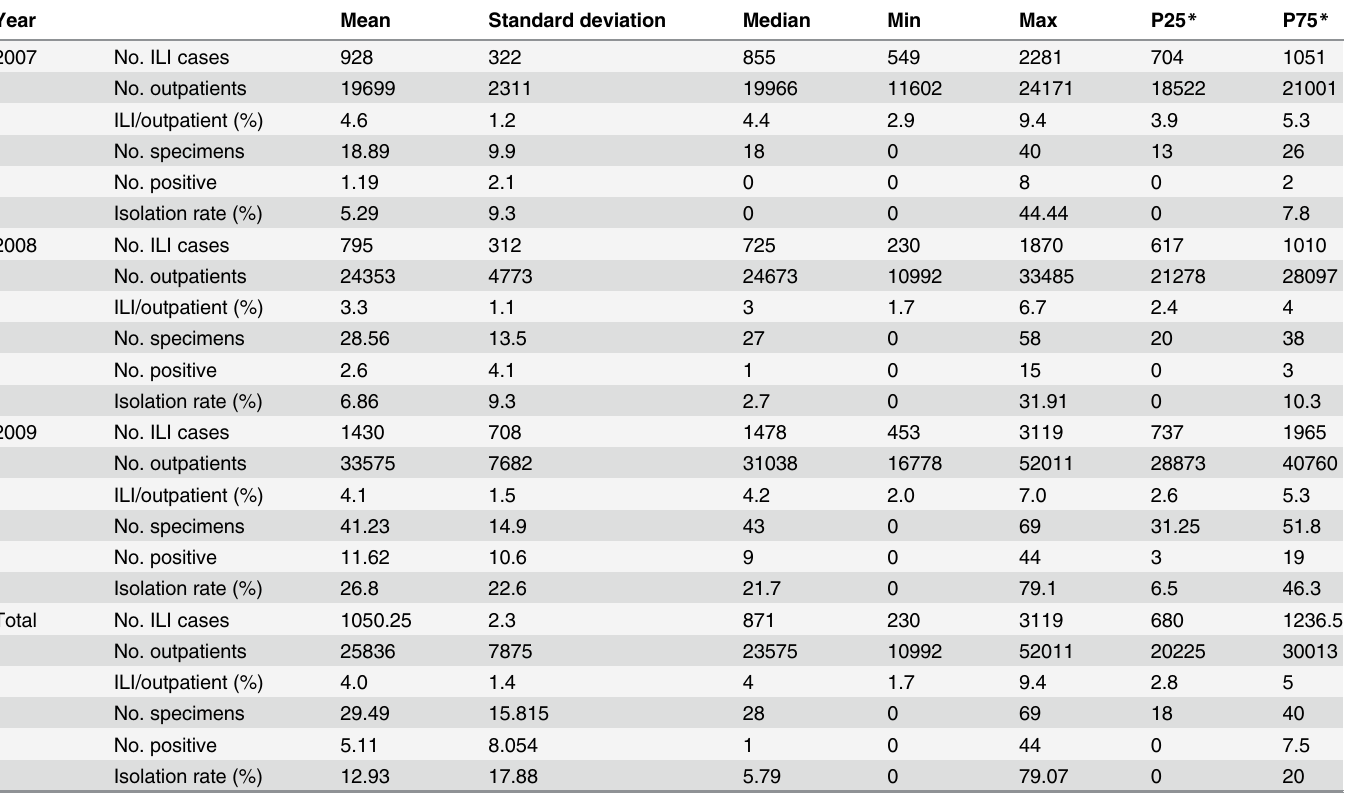
Table 1. Influenza-like illness (ILI) cases, outpatient visits, and influenza virus positive isolation rate by week (2007 – 2009, Zhuhai City,